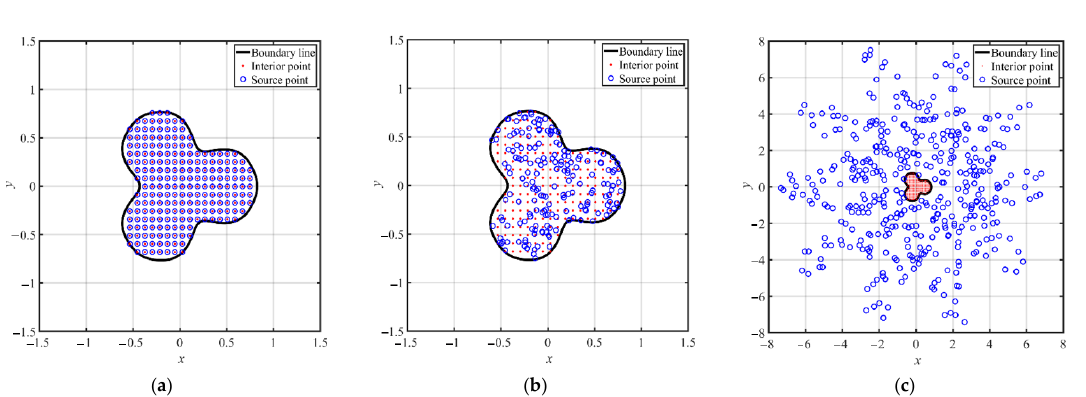
Figure 8. Collocation points of the three types in the application example 2. ( a ) Type A. ( b ) Type B. ( c ) Type C.